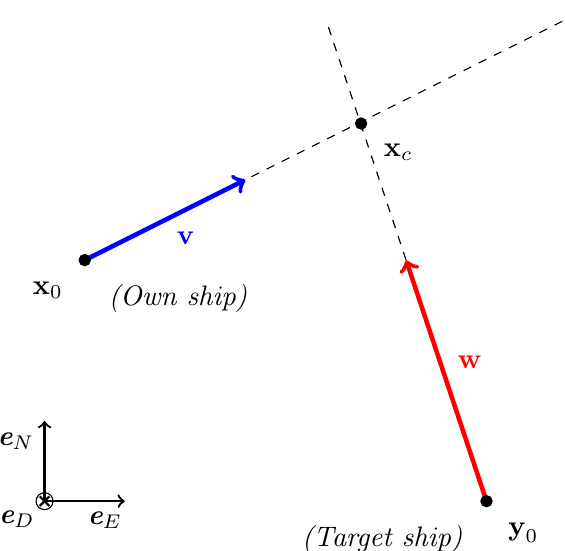
Figure 5. Symbols used to describe the considered